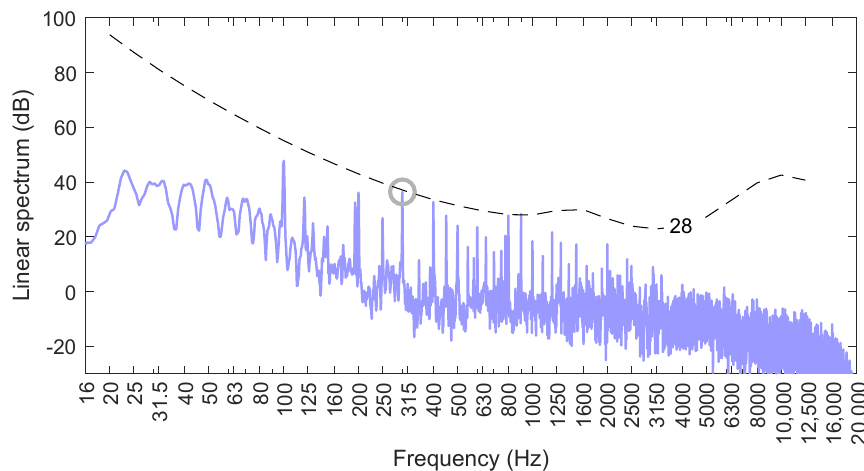
Figure 14. Comparison between the narrow band sound pressure spectrum and the equal loudness contour intersecting the highest frequency component around 300 Hz.